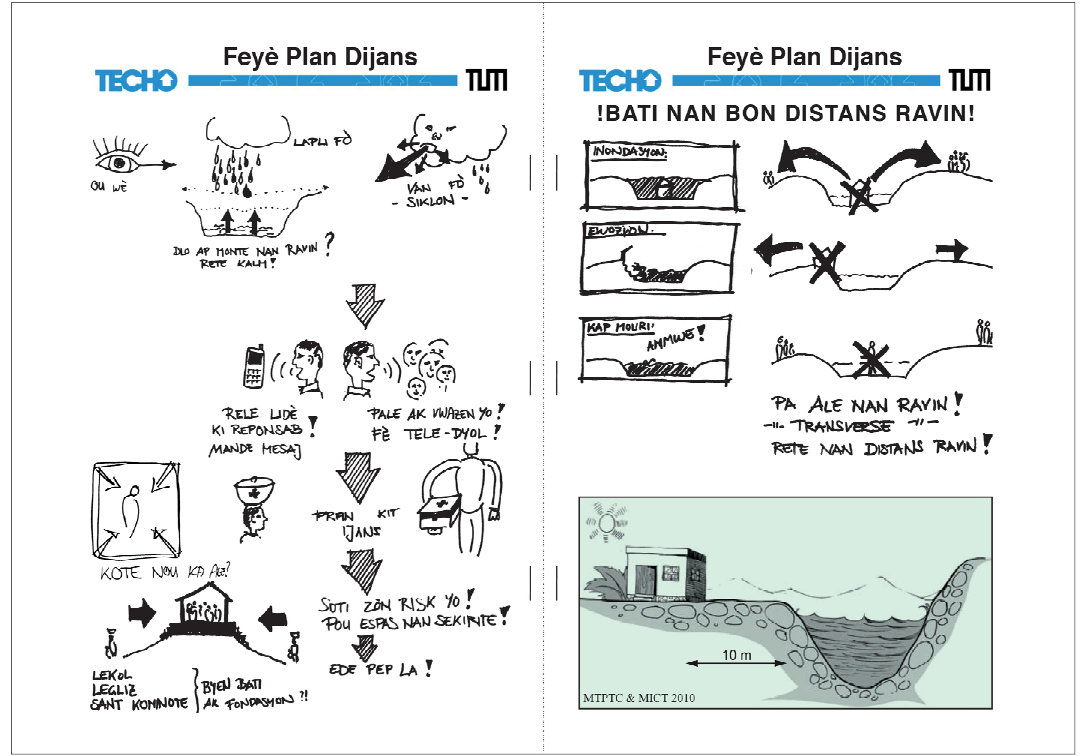
Figure 19. Excerpt from the flood risk awareness information